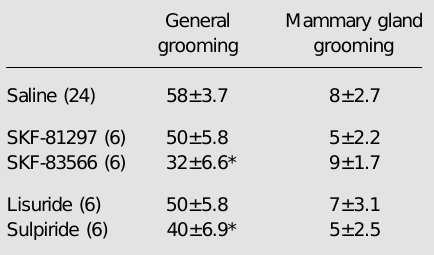
Table 1. Effects of stimulation and blockade of dopamine receptors on time (seconds) spent in grooming behavior by virgin rats.